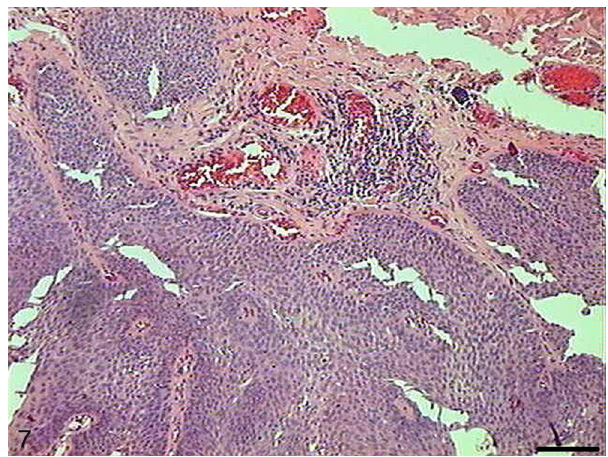
Figure 9 Grade I squamous carcinoma cells with AgNORs. Micrograph of grade I squamous carcinoma cells with AgNORs in the form of isolated lumps or forming large aggregates, with rounded or irregular shapes filling the entire nucleus or present in the nucleolus as satellites (AgNOR, bar = 10 (cid:2) m).